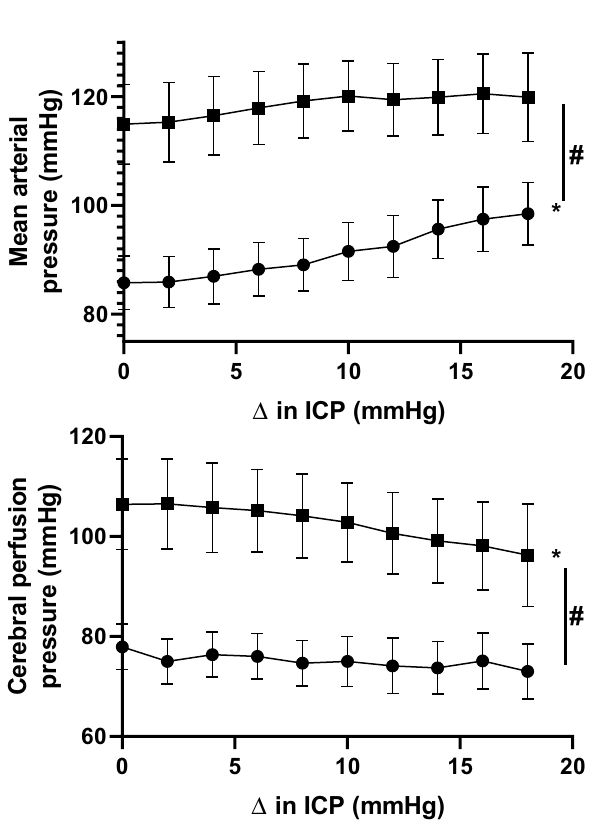
Figure 4. Mean response of arterial pressure and calculated cerebral perfusion pressure (CPP) to the increase in intracerebroventricular infusion of saline in the normotensive (filled circles; n = 6) and hypertensive (filled squares; n = 6) groups. Data are means ± SE and are plotted against change in intracranial pressure (ICP) from baseline. *Significant effect of time; # significant interaction between group and ICP (two-way